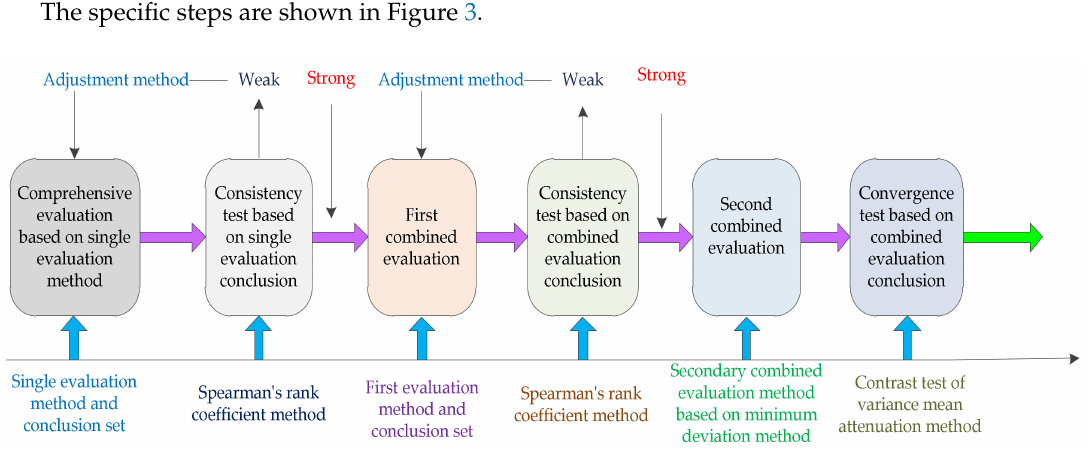
Figure 3. The construction idea of the secondary combined evaluation